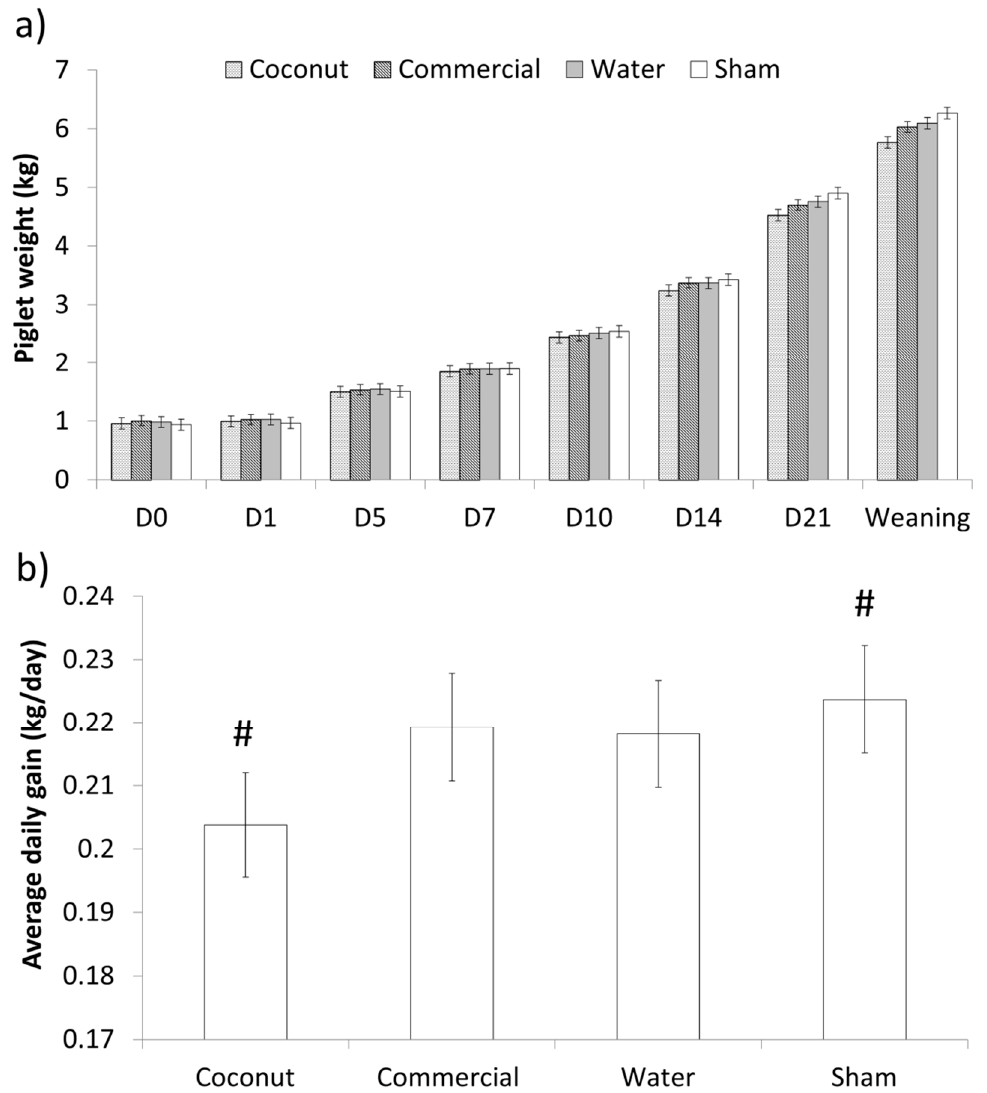
Figure 3. Preweaning weights ( a ) and average daily gain ( b ) of piglets born under 1.1 kg. Piglets were either given a 2 mL oral supplementation at 3 h postpartum (Coconut oil, commercial product or water) or were sham-dosed. Tendency for difference between treatments ( p = 0.07) is shown by #.